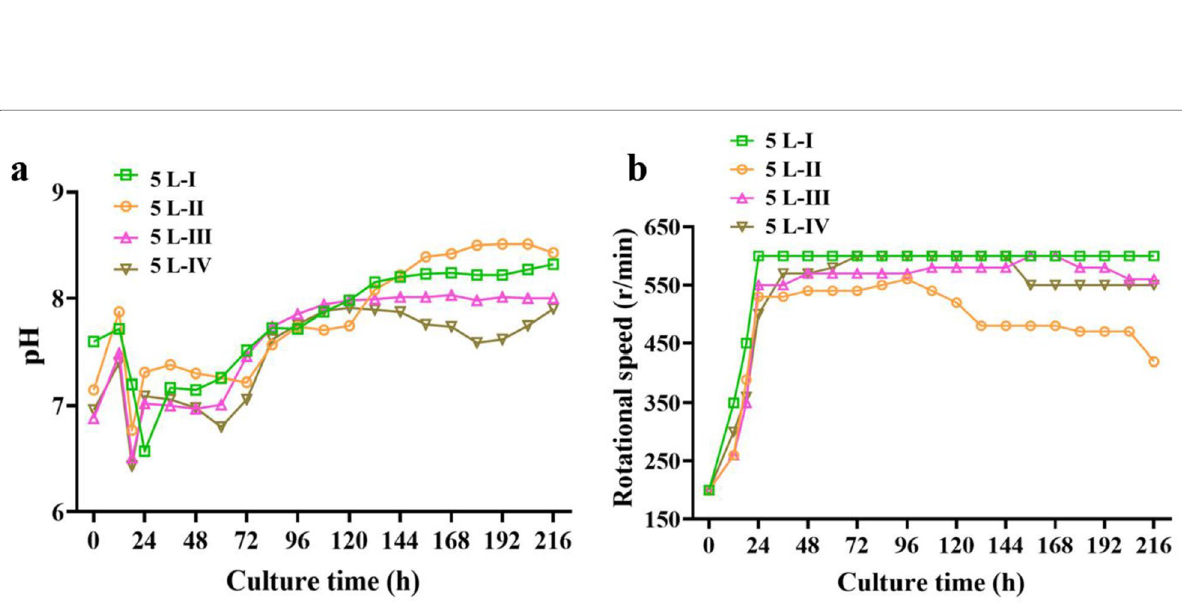
Fig. 10 Time courses of pH values ( a ) and rotational speed ( b ) in 5-L bioreactor (batch